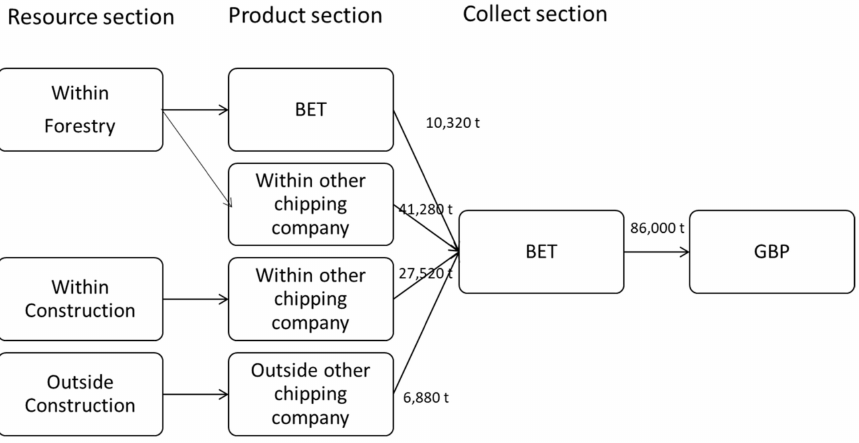
Figure 2. The flow of materials. Gifu Biomass Power Co., Ltd. (GBP) purchases 86,000 tons of wood chips annually from wood chip companies, including Biomass Energy Tokai Co., Ltd. (BET). Table 1. Fuel purchase amounts (purchase